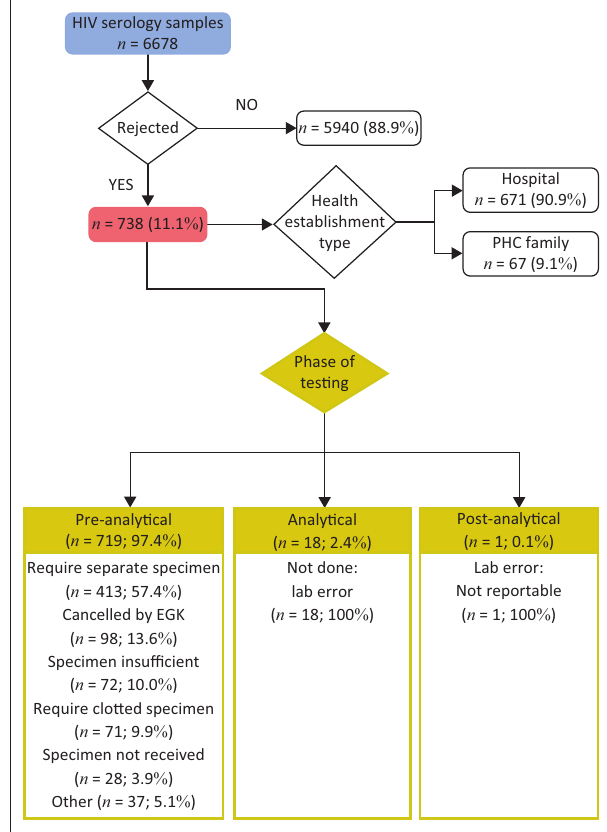
FIGURE 1: Rejection rates and criteria throughout the total testing process for HIV serology samples performed at the Department of Virology, National